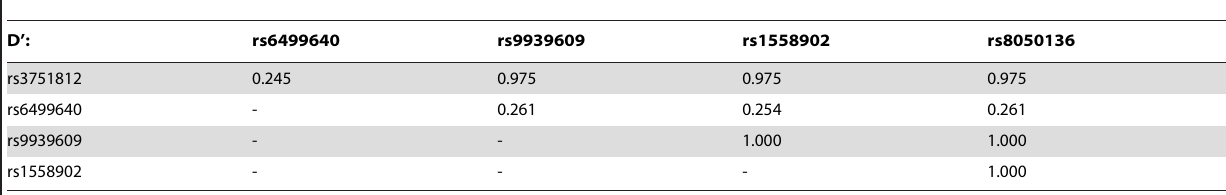
Table 3. Pairwise linkage disequilibrium.